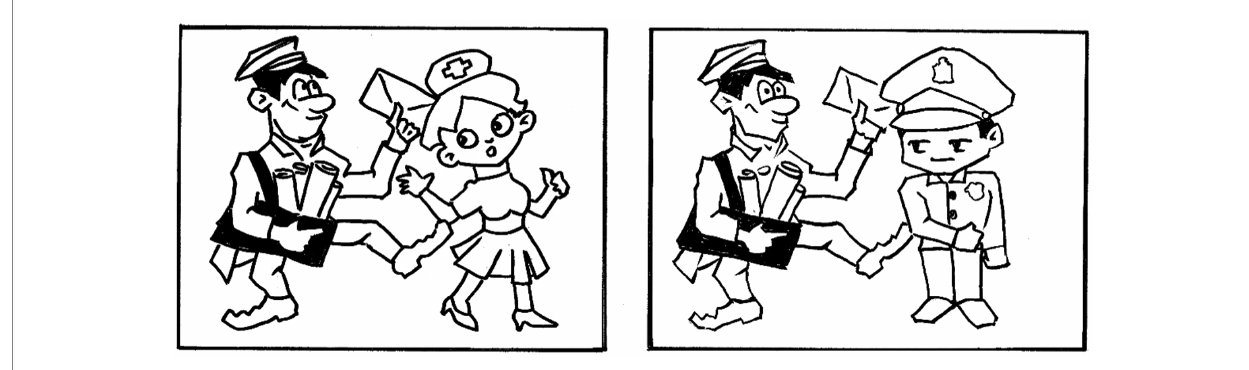
FIGURE 3 Prime (on the left) and target (on the right) pictures for sentences in